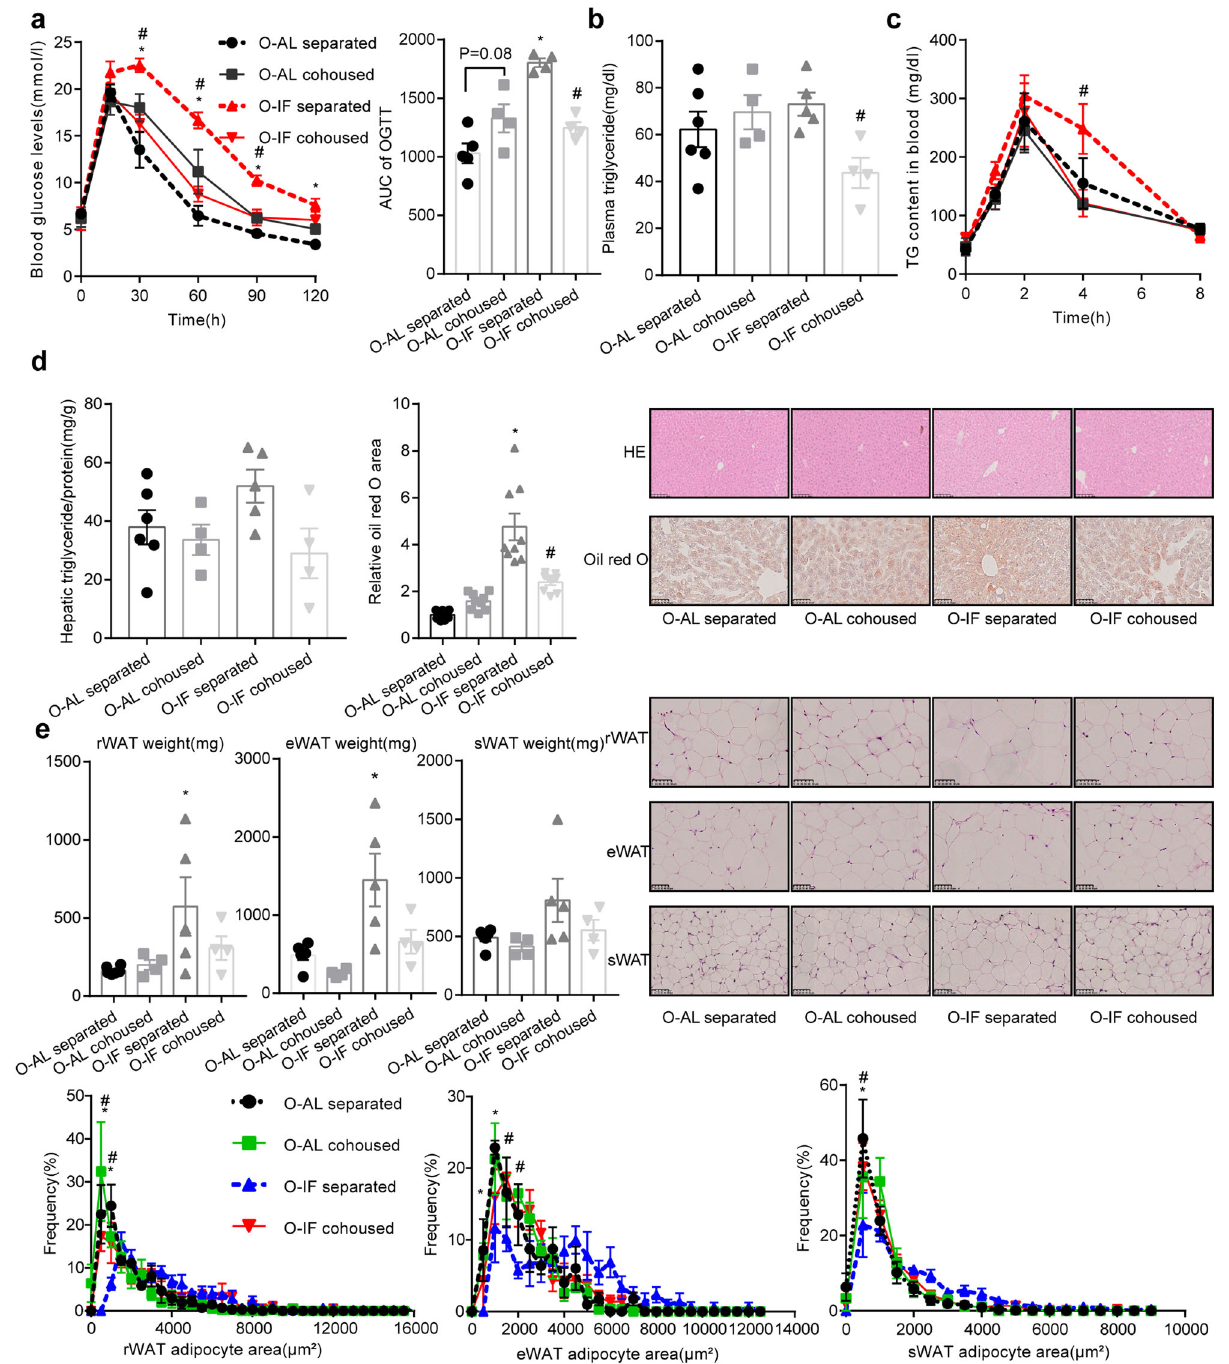
Fig. 6 Maternal intermittent fasting offspring co-housed with healthy mice shows improvement in glucose and lipid metabolism. O-AL and O-IF mice were co-housed for 10 weeks. Results were expressed as mean ± SEM. Two-way ANOVA was used for comparisons between multiple groups. * P < 0.05 vs. O-AL separated. # P < 0.05 vs. O-IF separated. a Glucose tolerance test and the area under curve. N = 5 for O-AL separated, 4 for O-AL cohoused, 4 for O-IF separated, and 4 for O-IF cohoused. b Plasma levels of triglyceride. N = 6 for O-AL separated, 4 for O-AL cohoused, 5 for O-IF separated, and 4 for O-IF cohoused. c Plasma levels of triglyceride after oral administration of olive oil. N = 5 for O-AL separated, 4 for O-AL cohoused, 4 for O-IF separated, and 4 for O-IF cohoused. d Triglyceride contents, oil red O and H&E staining of liver. N = 6 for O-AL separated, 4 for O-AL cohoused, 5 for O-IF separated, and 4 for O-IF cohoused. e Fat mass, H&E staining and adipocyte size of rWAT, eWAT, sWAT. N = 6 for O-AL separated, 4 for O-AL cohoused, 5 for O-IF separated, and 4 for O-IF